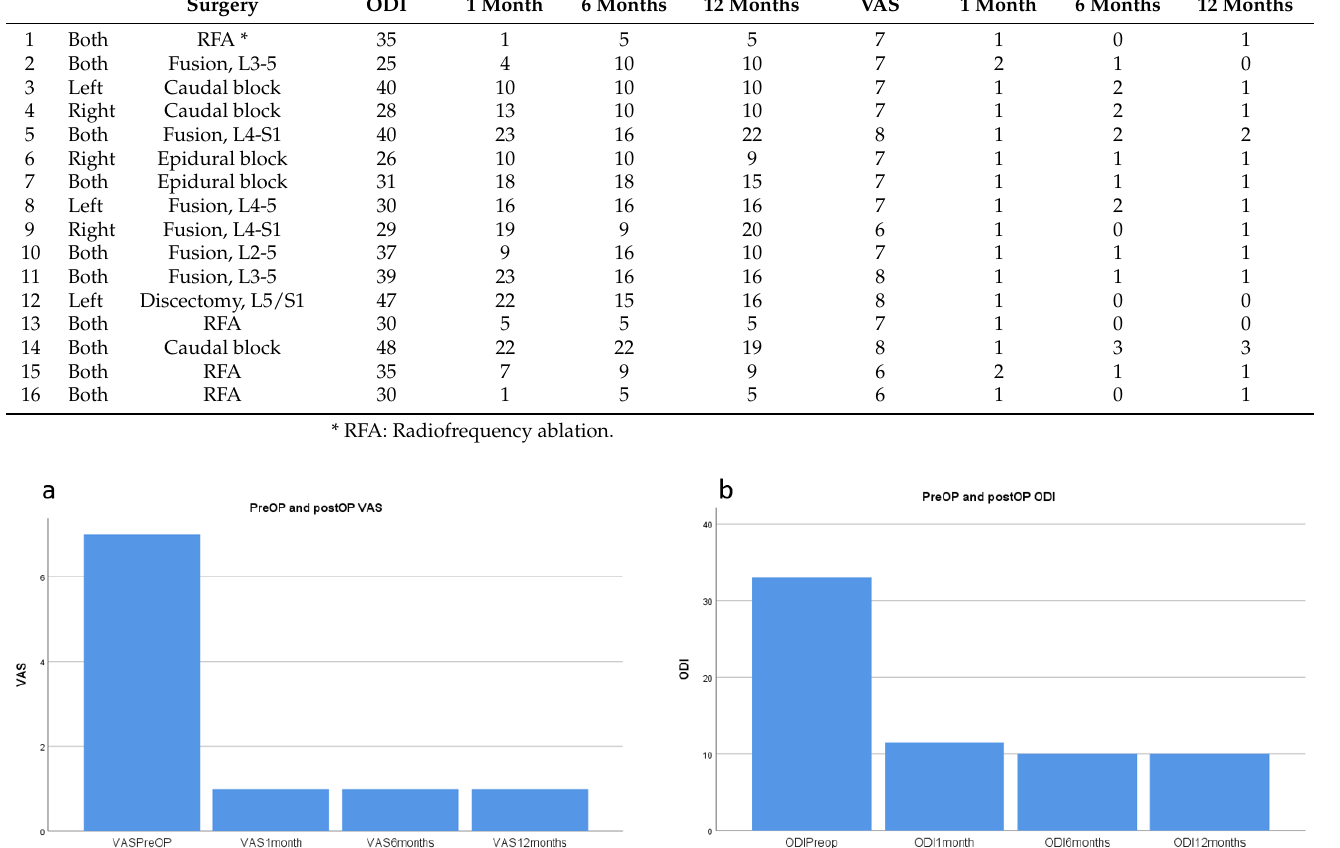
Table 1. Summary of the patients and their treatment results. Figure 3. Fluoroscopes were used to guide the ablation point. ( a ) S1 foramen; ( b ) S2 foramen; ( c ) L5 dorsal ramus, which is located at the junction of the sacral alar and promontory.